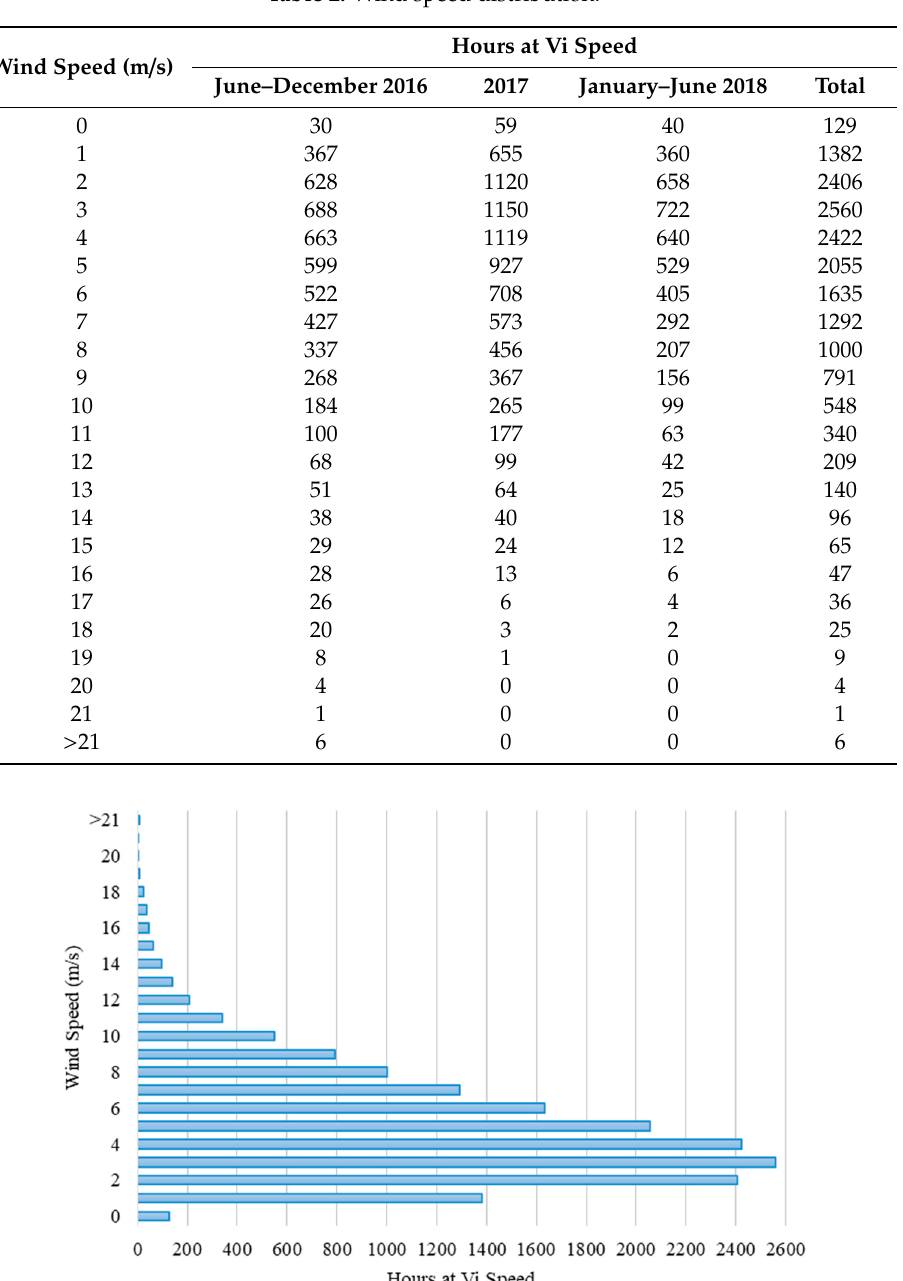
Table 2. Wind speed distribution.